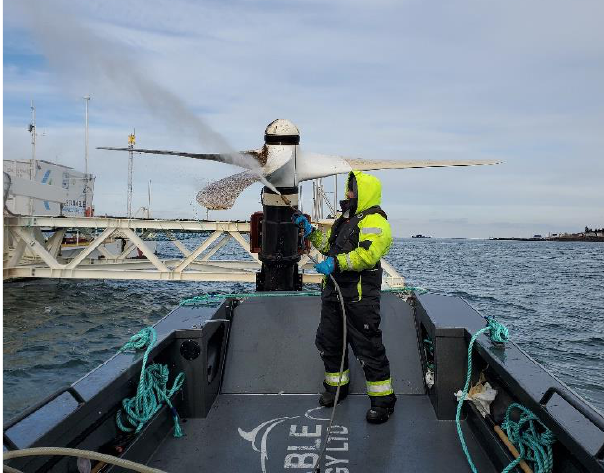
Fig. 7 SIT 4 rotor during on site